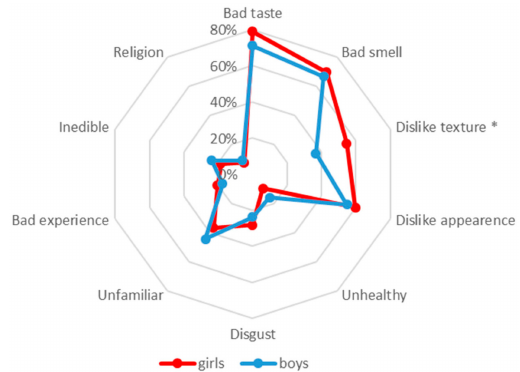
Figure 3. Reasons for rejecting the food stimuli for girls and boys (pumpkin n = 17 / 19; kale n = 4 / 4; seaweed n = 6 / 16; physalis n = 4 / 10; caviar n = 11 / 23; herring n = 29 / 30; anchovy n = 45 / 32; blue cheese n = 27 / 40; deer salami n = 9 / 10); n = number of girls / boys rejecting a food stimulus; the particular frequencies correspond to the lines below them and 0% corresponds to the center of the spider chart. Level of significance: * p ≤